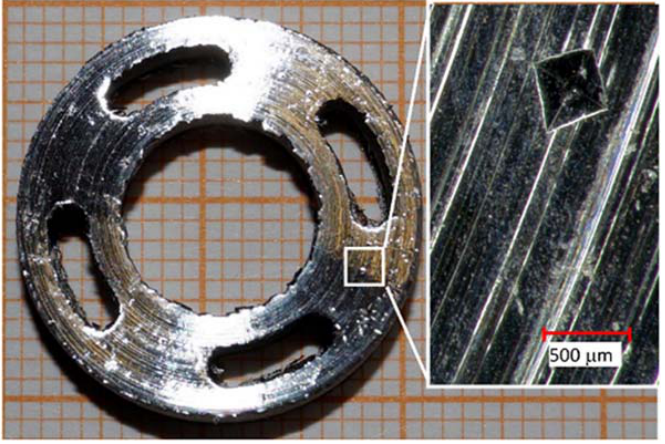
Figure 8. Test specimen for hardness determination. Hardness was measured on both sides ( n = 10 for each case and side).